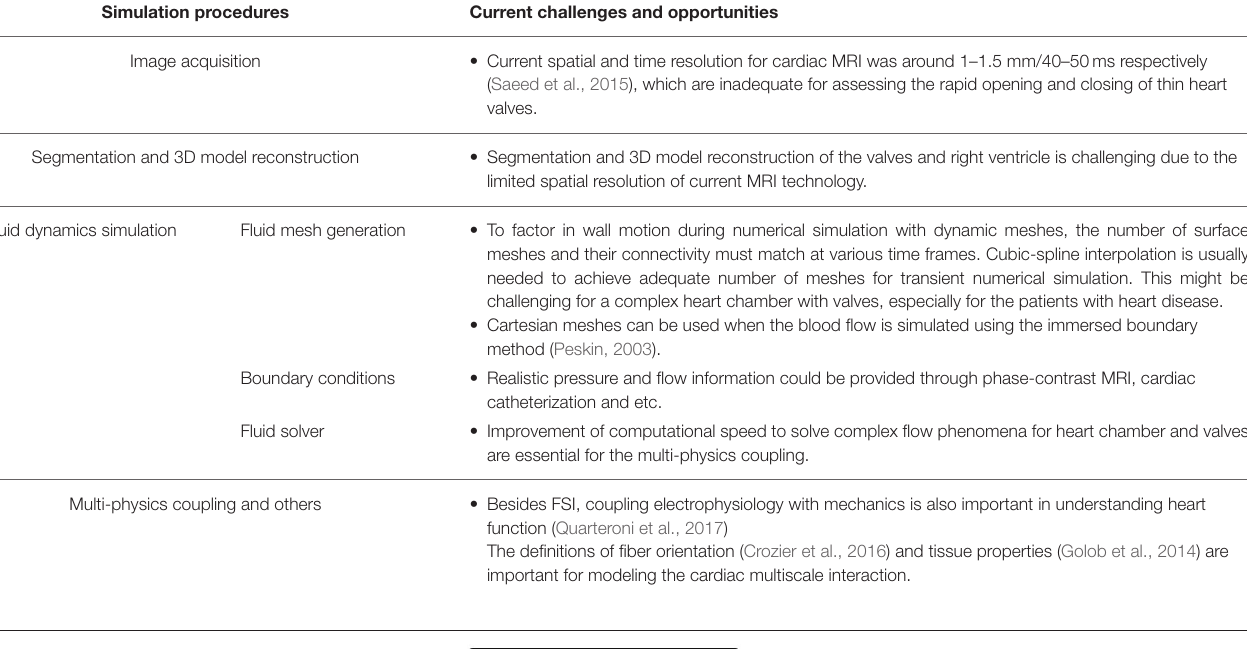
TABLE 3 | Current challenges and opportunities in numerical simulation of intra-cardiac flow.